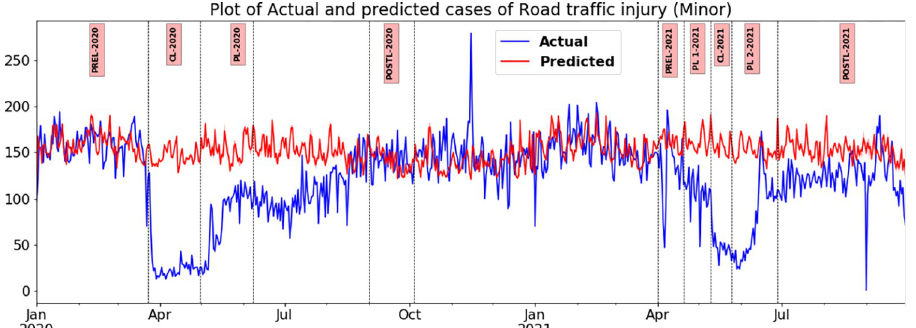
Fig 6. Plot of the daily number of minor Road Traffic Injuries (RTI-Minor) in TN actual versus predicted during various phases of wave one and wave two in 2020 and 2021.